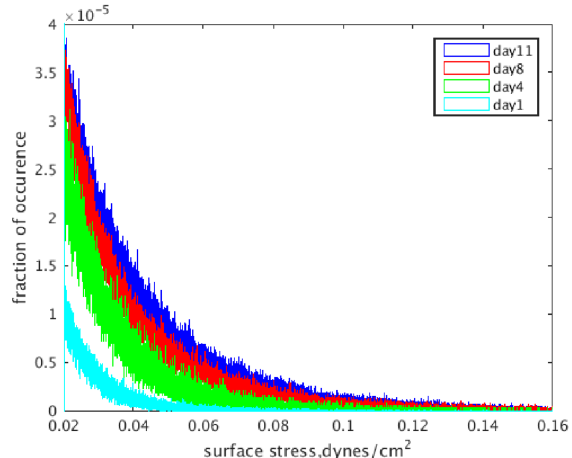
Figure 5. Wall shear stress distributions based on the day a construct was removed from culture and imaged.